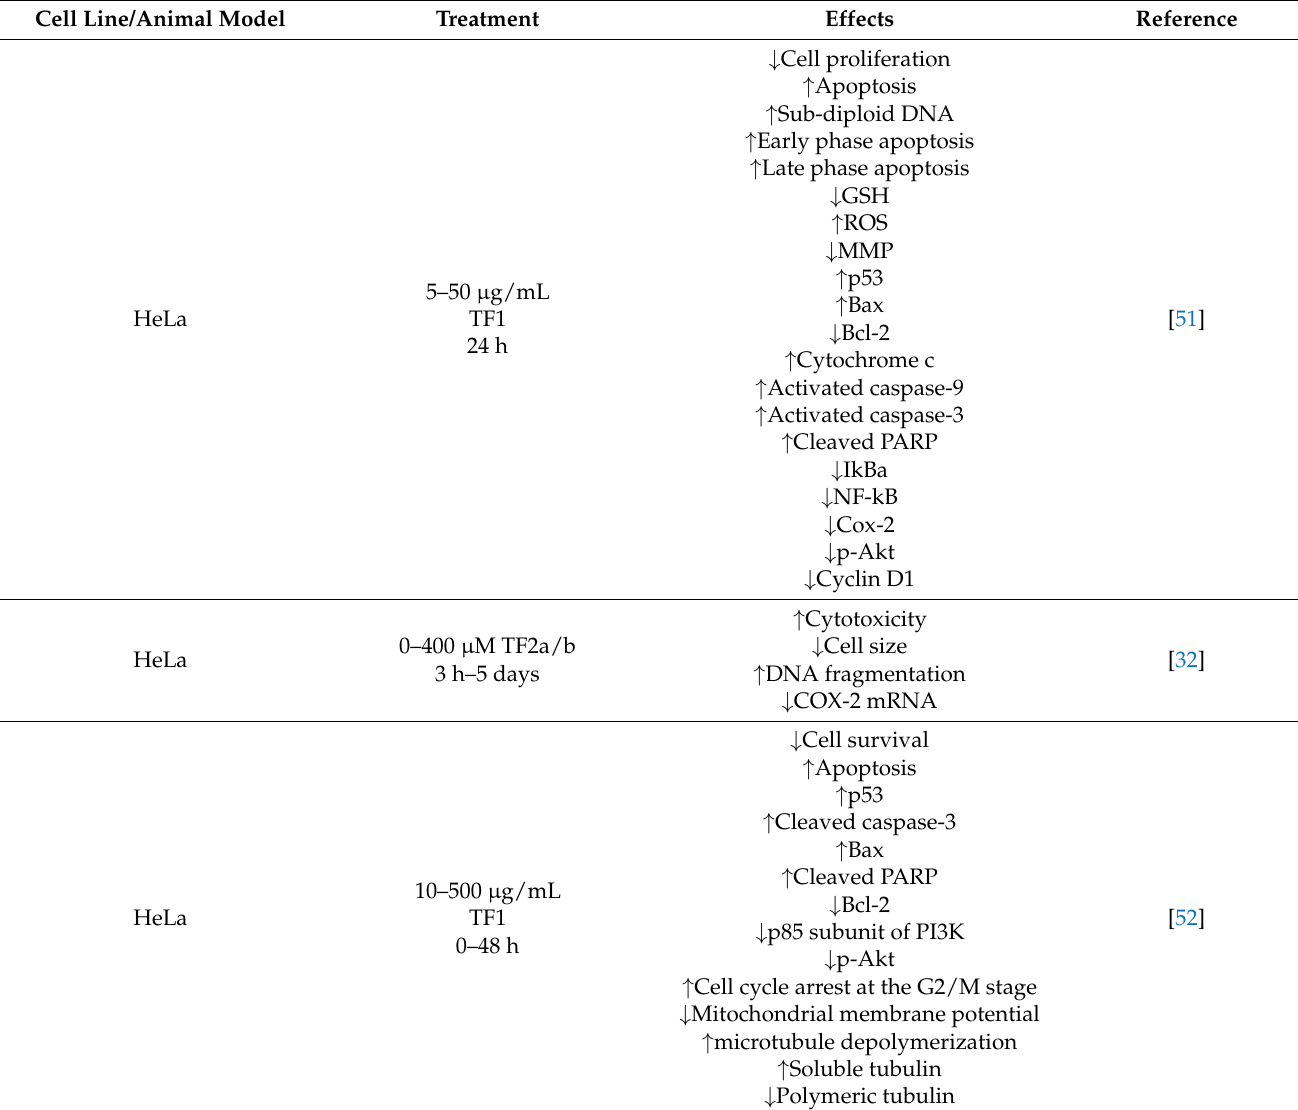
Table 6. Effects of theaflavins in cervical